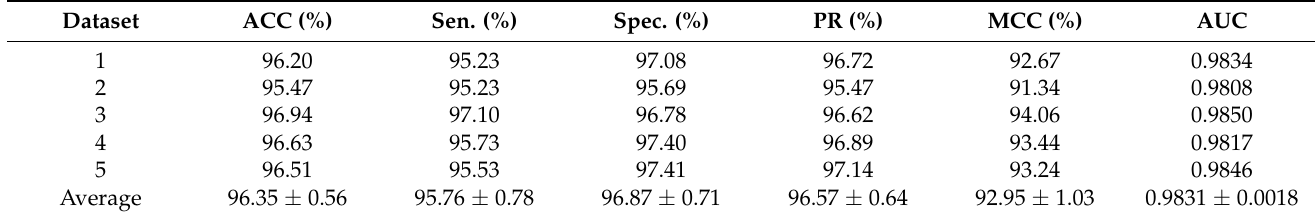
Table 2. Five-fold CV results performed by the proposed model on the Human PPIs dataset.